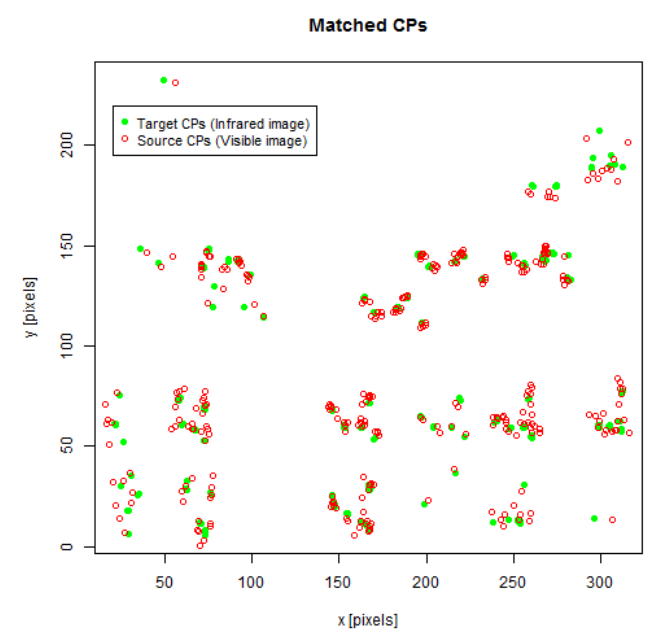
Figure 19. Plot of corresponding points in target coordinate space. Corresponding points (CP) from target images are plotted in green and CPs from source images after registration and transformation are shown in